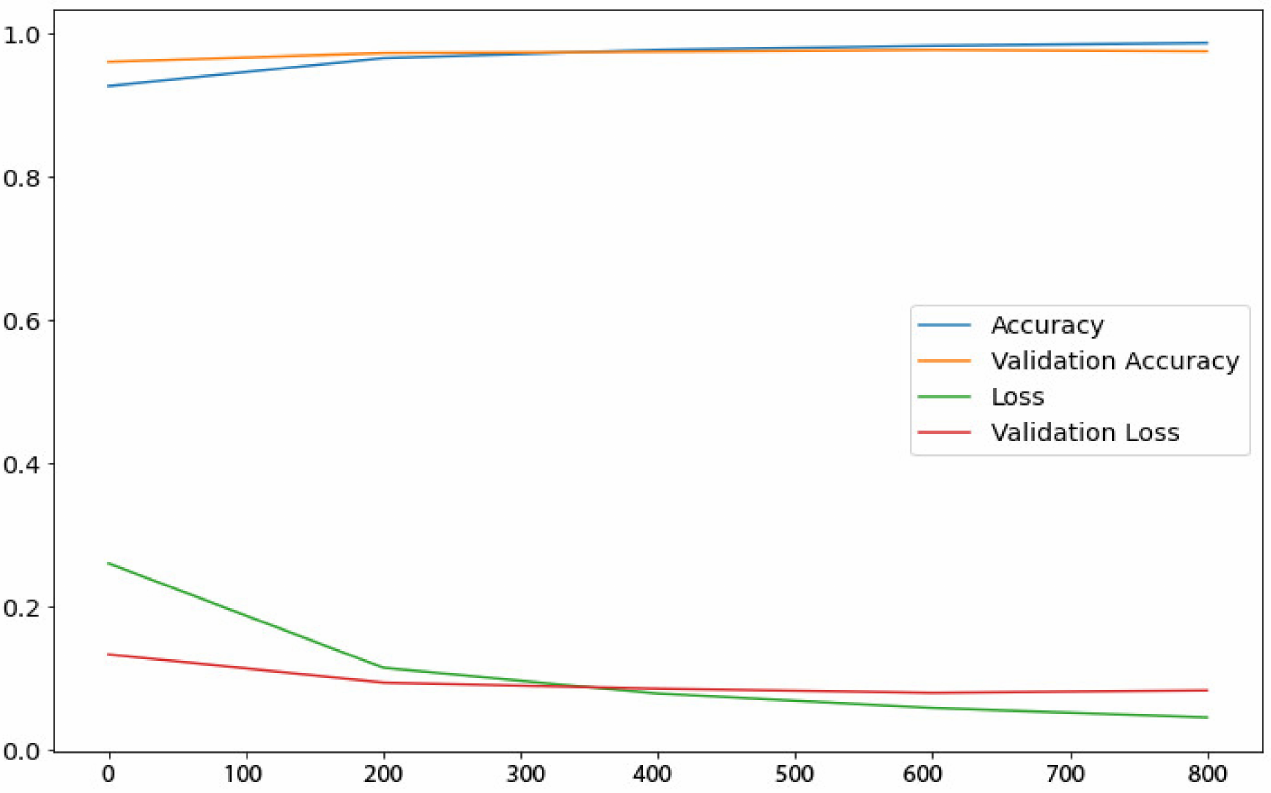
Figure 5. Performance evaluation of the proposed model: accuracy and loss